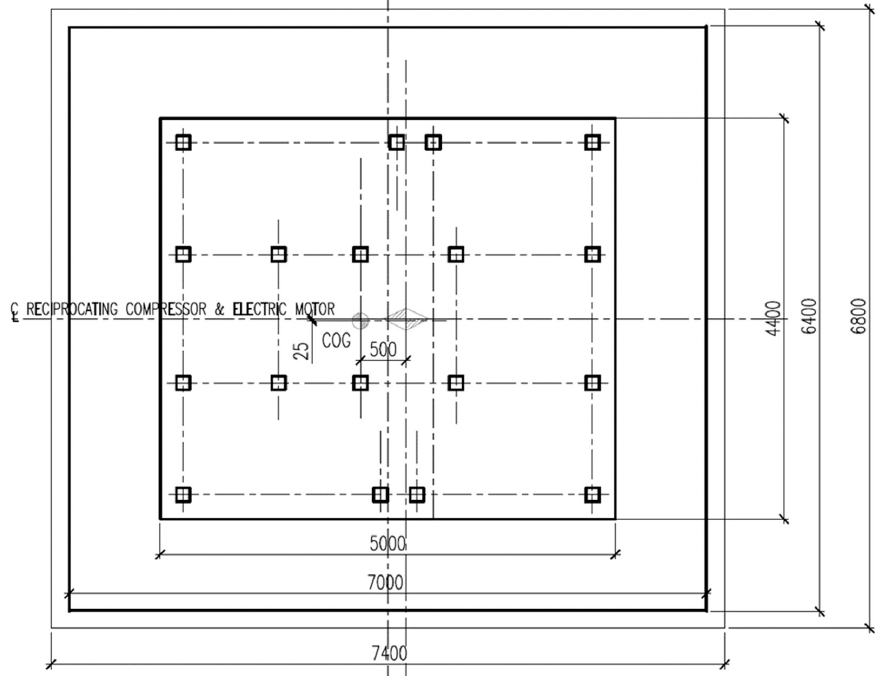
Figure 6. G 0 values obtained for the soil at different depths for a general DH test.